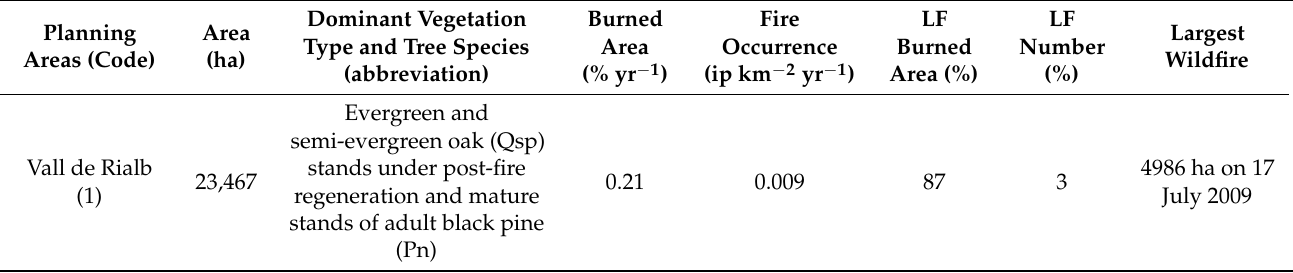
Table A1. Summary table with main features of the planning areas in the study and observed wildfire activity from 1983 to 2015. See planning area locations in Figure 1. We considered 100 ha as the large fire (LF) threshold. The wildfire activity data was summarized collectively for adjacent planning areas. The wildfire season was determined from the cumulative burned area (Figure